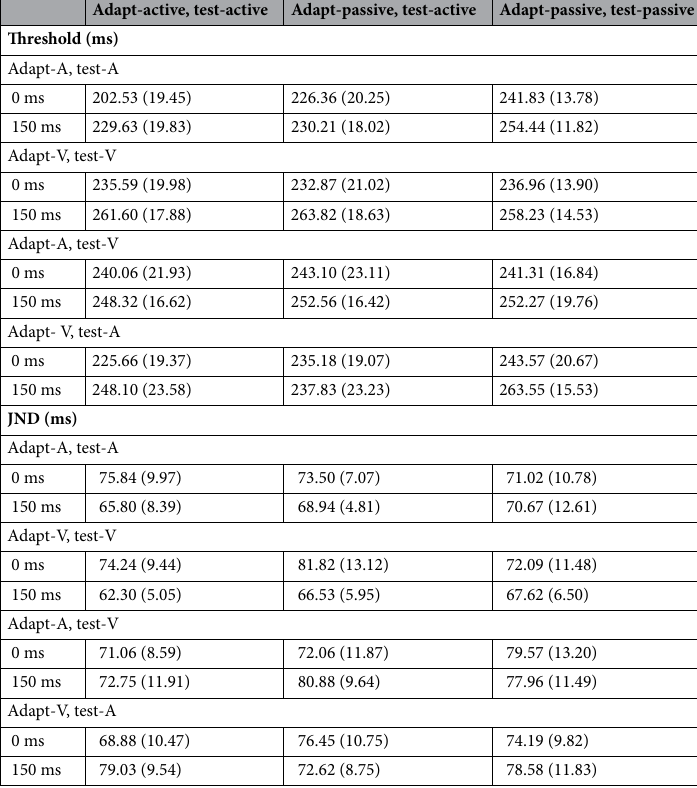
Table 1. Mean (standard error of mean, s.e.m.) thresholds and JNDs for each condition.